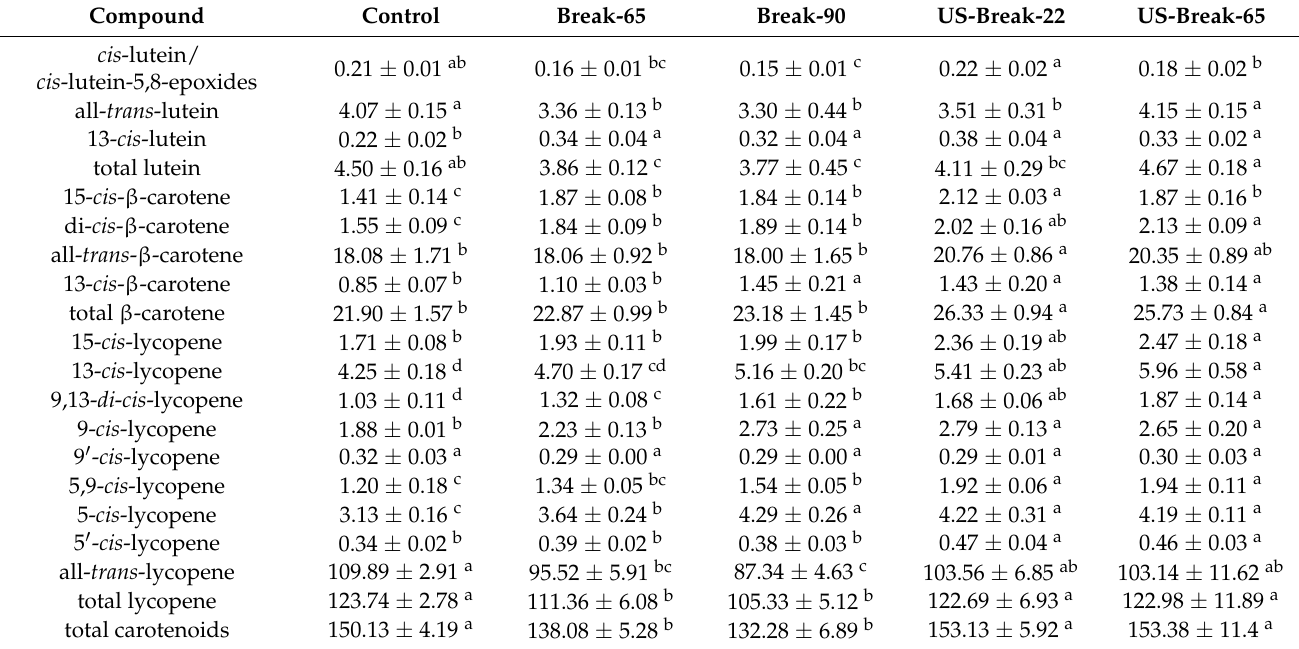
Table 3. Effects of different breaking treatments on the content (mg/100 g DW) of carotenoids in tomato pastes.